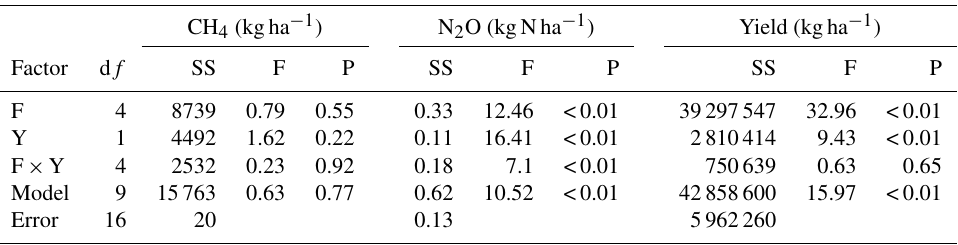
Table 2. Two-way ANOVA for the effects of fertilizer (F) application and year (Y) on CH 4 and N 2 O emissions, and rice grain yields in rice paddies.